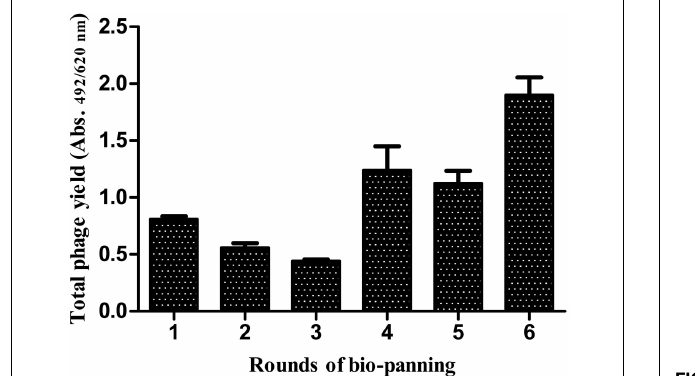
FIGURE 7 | Peptide ELISA . Different peptide sequences (representing linear HA epitopes) were synthesized and tested against the monoclonal phage-display antibodies for analysis of the binding activity. The C5 antibody, which was found to react with all the four HA peptides was used for development of the diagnostic ELISA